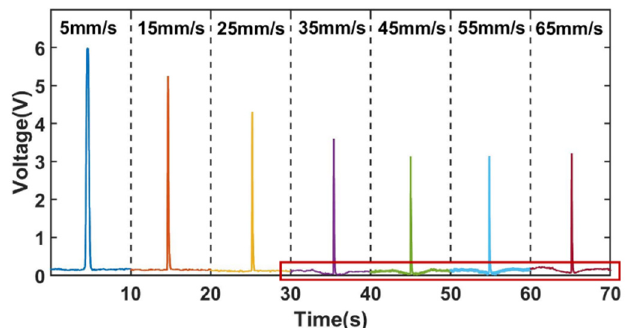
Figure 10. Comparison of signals at different velocities for 350 μ m iron.